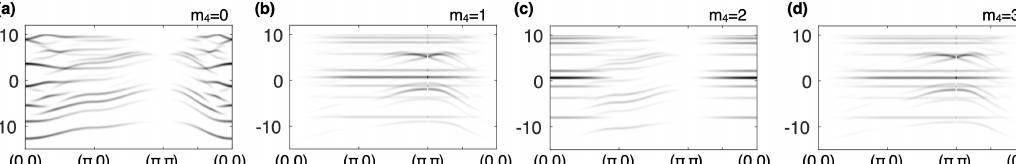
Figure 9: Two-hole spectra as in Fig. 8, but for fermionic holes. Again, all m ( 1 ) m sectors were included and a maximum string length ℓ 3 = 3 and a string potential for an Ising background. considered t / J z